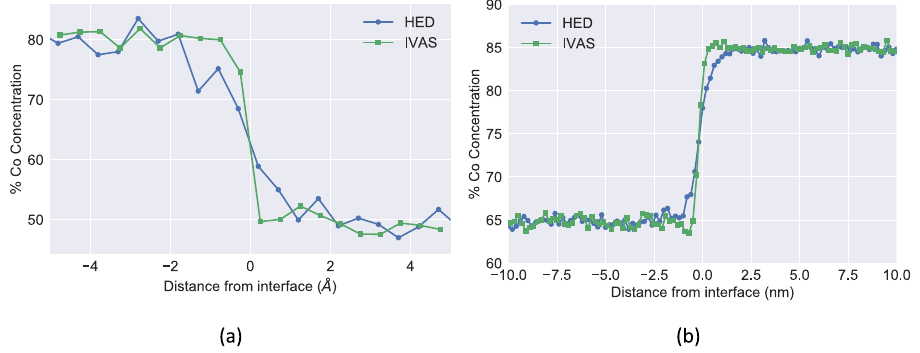
Figure 6. Proxigram comparisons on the MD and IVAS generated synthetic datasets. The Proxigram concentration profile derived from IVAS display a narrower interfacial compared with the HED method. ( a ) Proxigram concentration profile from the synthetic MD layered structure using HED and IVAS, ( b ) Proxigram concentration profile obtained from the synthetic IVAS dataset using HED and